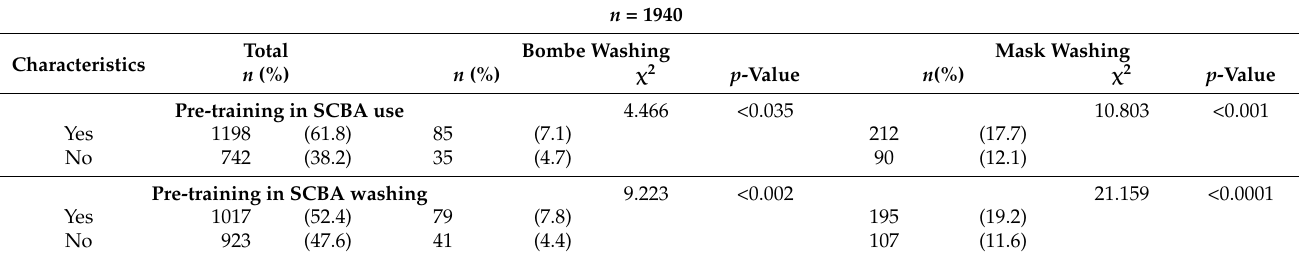
Table 2. Associations between pre-training in SCBA and decontamination